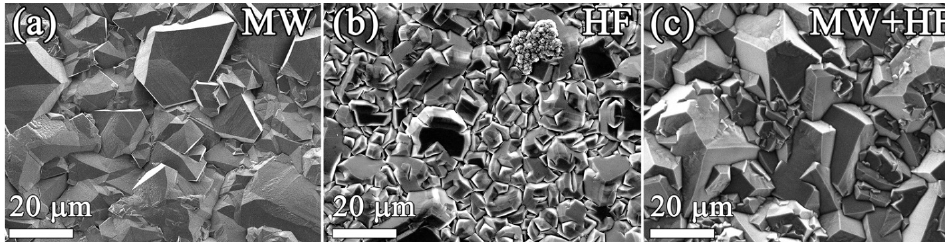
Figure 3. SEM images of three types of films: ( a ) MW CVD; ( b ) HF CVD; ( c ) combined MW+HF CVD. Images were taken in the “secondary electrons” (SE) mode of the microscope.